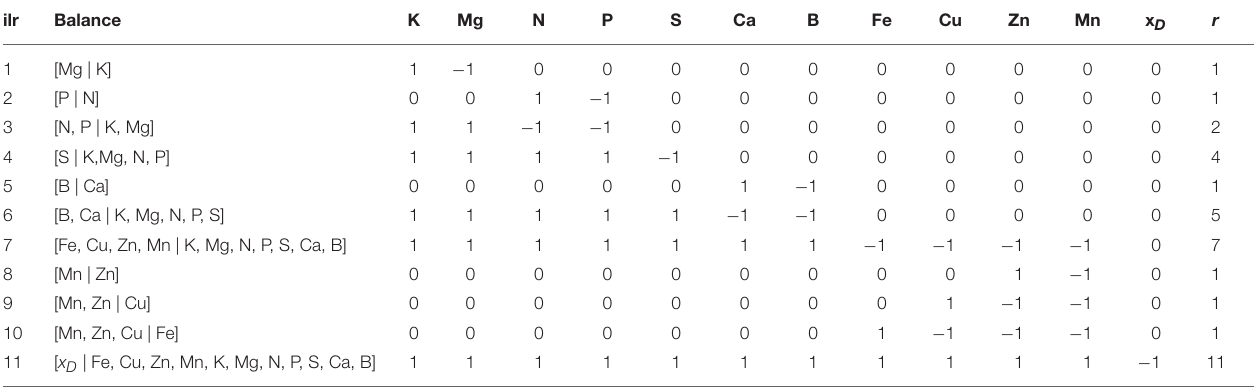
TABLE 2 | Sequential binary partitions of tomato leaf analytical data. ilr Balance